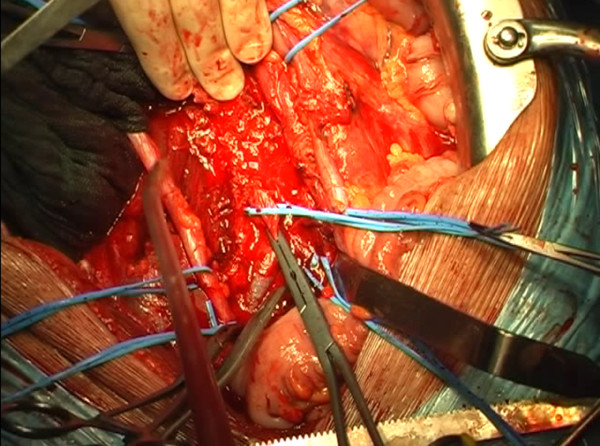
The operative field after the complete removal of the residual mass, the inferior vena cava and a part of psoas muscle.